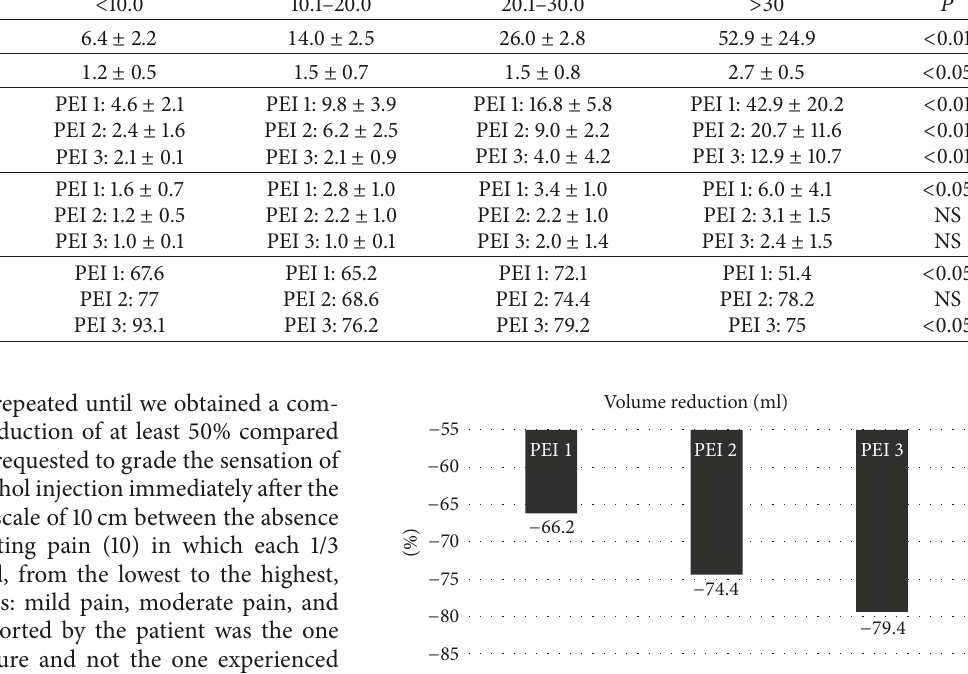
( ≤ 10 ml versus other volumes, 𝑃 < 0.01 ). The baseline volume was significantly different among the four groups ( 𝑃 < 0.01 ). The number of PEI was significantly higher in the > 30.0 ml group versus the other groups ( 𝑃 < 0.05 ). As expected, the higher the fluid drained was, the larger the cyst was ( > 30.0 ml group versus 20.1–30.0 ml group versus 10.1–20.0 ml group and versus ≤ 10 ml group; 𝑃 for trend < 0.01), whereas the alcohol injected was significantly higher only at the first PEI in the > 30 ml group ( 𝑃 < 0.05 ). The > 30.0 ml group obtained the smallest percent reduction versus baseline after the first PEI ( 𝑃 < 0.05 ), whereas the ≤ 10.0 ml obtained the greatest percent reduction versus baseline after the third PEI ( 𝑃 < 0.05 ) (Table 1). In the whole group of patients, the volume reduction was 66% after the first, 74.4% after the second, and 79.4% after the third PEI treatment ( 𝑃 < 0.01 versus baseline) (Figure 1). A positive correlation between the volume and the number of PEI treatments was found: the vast majority (85.7%) of cysts ≤ 10 ml were cured by just one PEI, whereas 33.3% and 66.7% of cysts > 30 ml required 2 and 3 PEI, respectively ( 𝑃 < 0.01 ) (Figure 2). Multiple linear regression revealed that, among the considered parameters, only the baseline volume was predictive of response to PEI ( 𝑃 < 0.01 ). The sensation of pain reported during PEI was virtually absent (78.3%), mild (17.4%), or moderate (4.1%). In all cases, this was a transient sensation of pain with relief within minutes. No patient felt intense pain and none suffered other complications. PCS-12 and MCS-12 both significantly improved from pre- to the posttreatment ( 50.1 ± 8.3 versus 54.7 ± 5.4 and 39.5 ± 13.1 versus 48.5 ± 6.8 , respectively; 𝑃 < 0.01